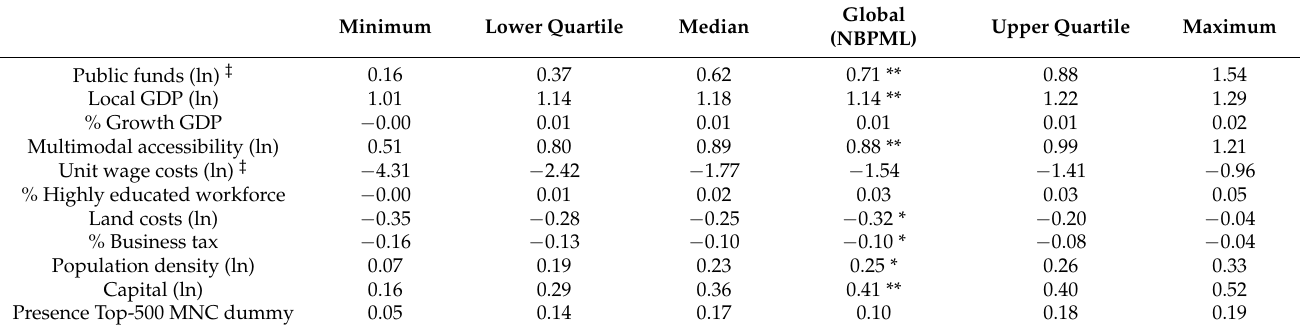
Table 5. Geographically Weighted Negative Binomial Regression Estimates.